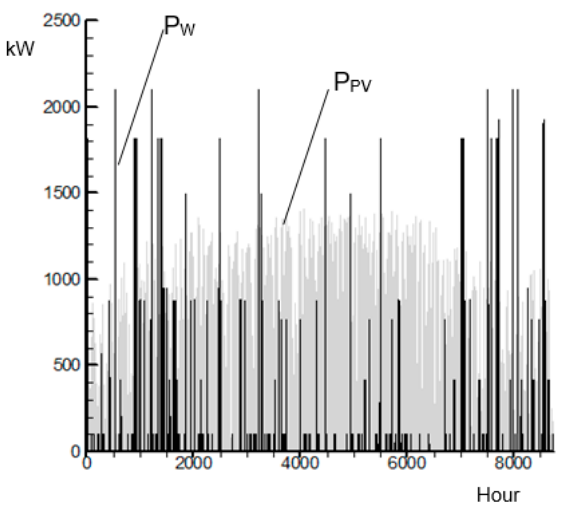
Figure 10. Photovoltaic and wave power output.